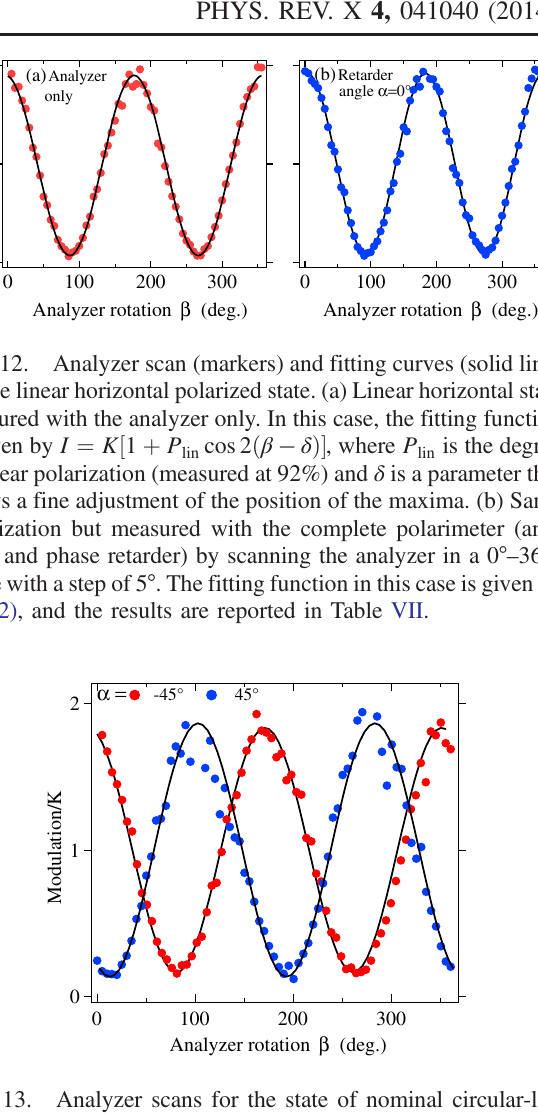
FIG. 13. Analyzer scans for the state of nominal circular-left polarization at α ¼ − 45 ∘ (red) and α ¼ − 45 ∘ (blue). These data allow us to measure S 2 and S 3